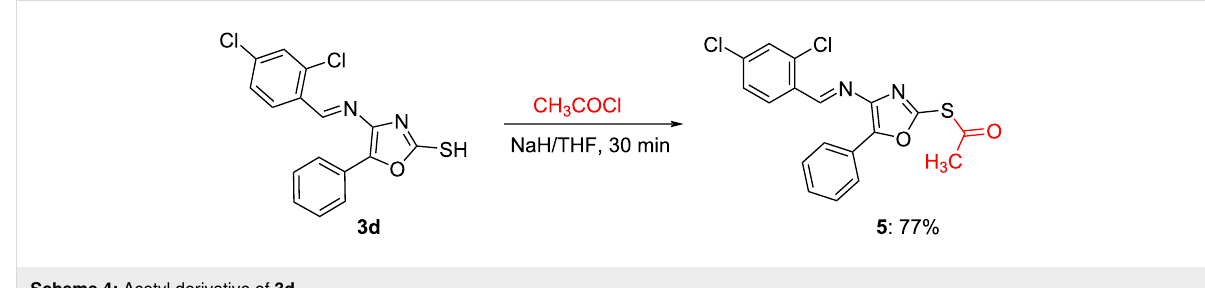
Further, the utility of the thiol group in 3 for the generation of a library of compounds was demonstrated by the simple acetyla- tion and alkylation (Scheme 4 and Scheme 5). The acetylation of the thiol group in 3d proceeded smoothly with acetyl chlo- ride in the presence of sodium hydride to afford 5 in good yield.